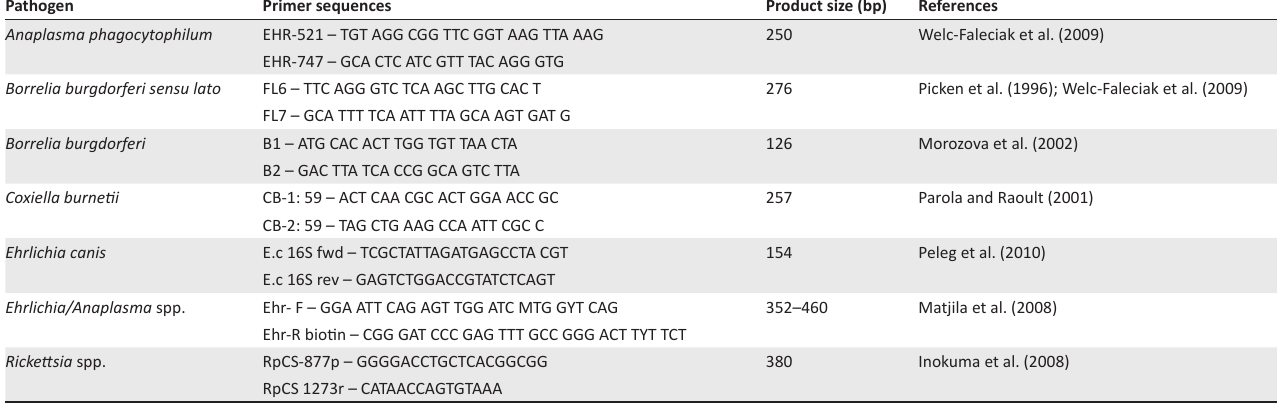
TABLE 1: Oligonucleotide sequences used for polymerase chain reaction amplification of the target pathogens. Pathogen